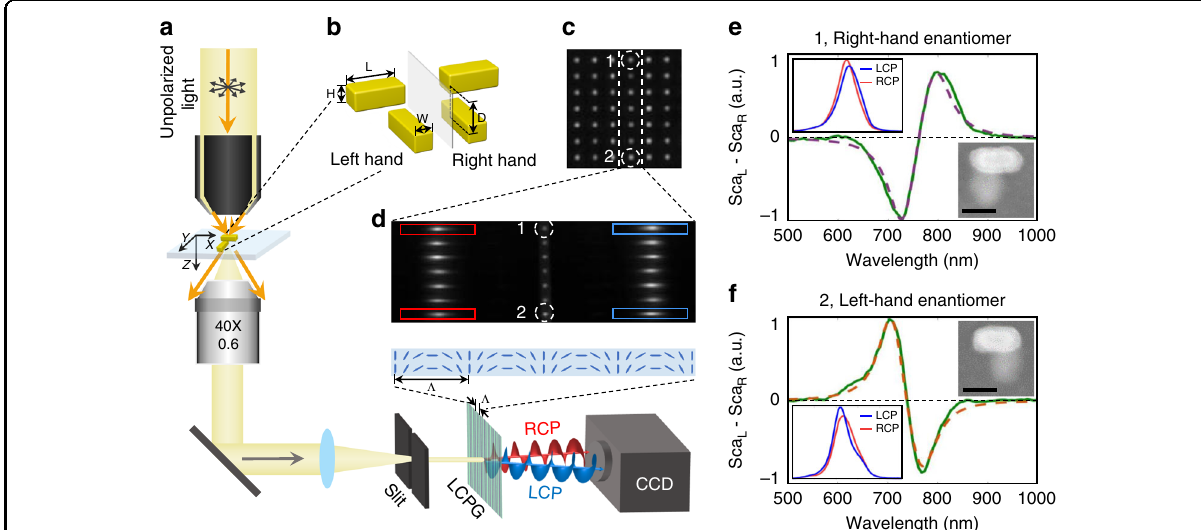
Fig. 1 Polarization-dispersive imaging spectrometer for single nanostructure SCD spectroscopy. a Schematic drawing of the LCPG-based polarization-dispersive spectrometer. The inset illustrates the director distribution of the liquid crystal in the grating. b Structure of the vertically coupled nanorod pairs used in this work. c Dark- fi eld image of an array of vertically coupled nanorod pairs with different geometrical parameters. The period of the array is 3 μ m. d Spectral image of array of nanorod pairs labeled in ( c ). The RCP and LCP components are labeled with red and blue boxes, respectively. e , f are the SCD spectra of sample 1 and 2 in ( c ), respectively. The insets show the correlated SEM image of samples, as well as the left-hand and right-hand circularly polarized components of the scattered light of sample labeled in ( d ). Scale bar: 100